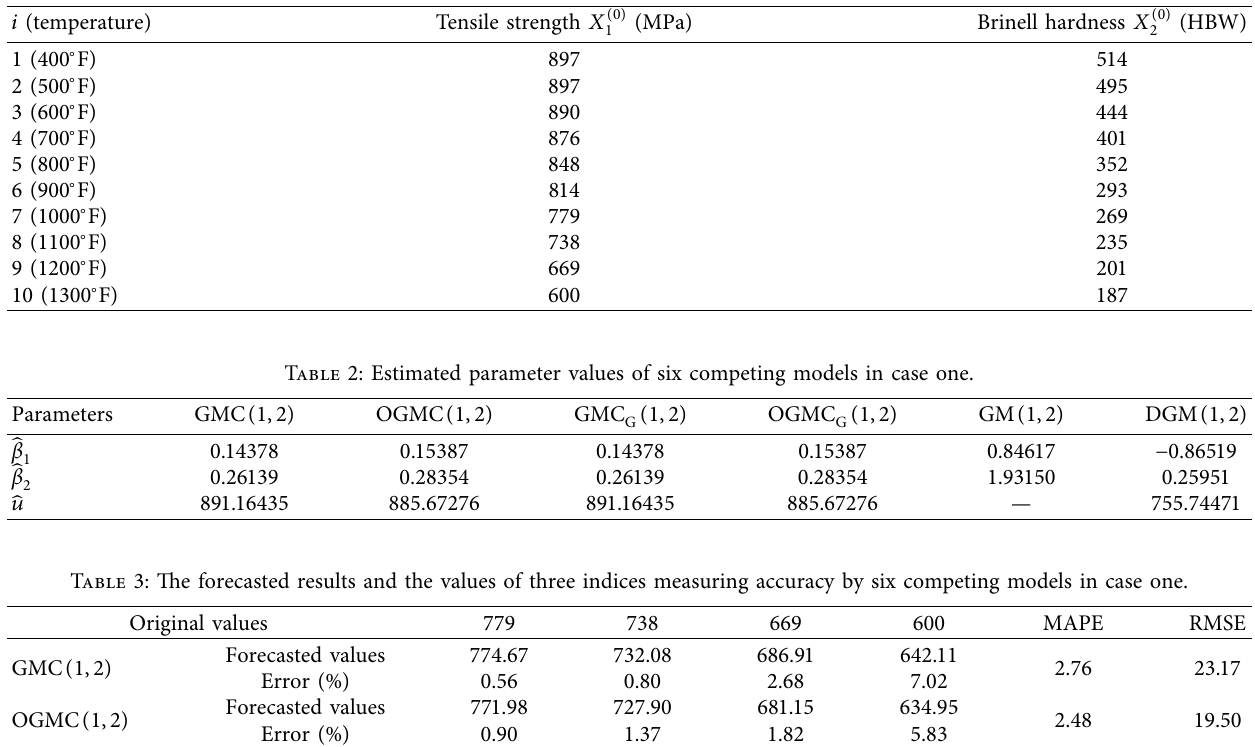
Table 1: Original data in case one.